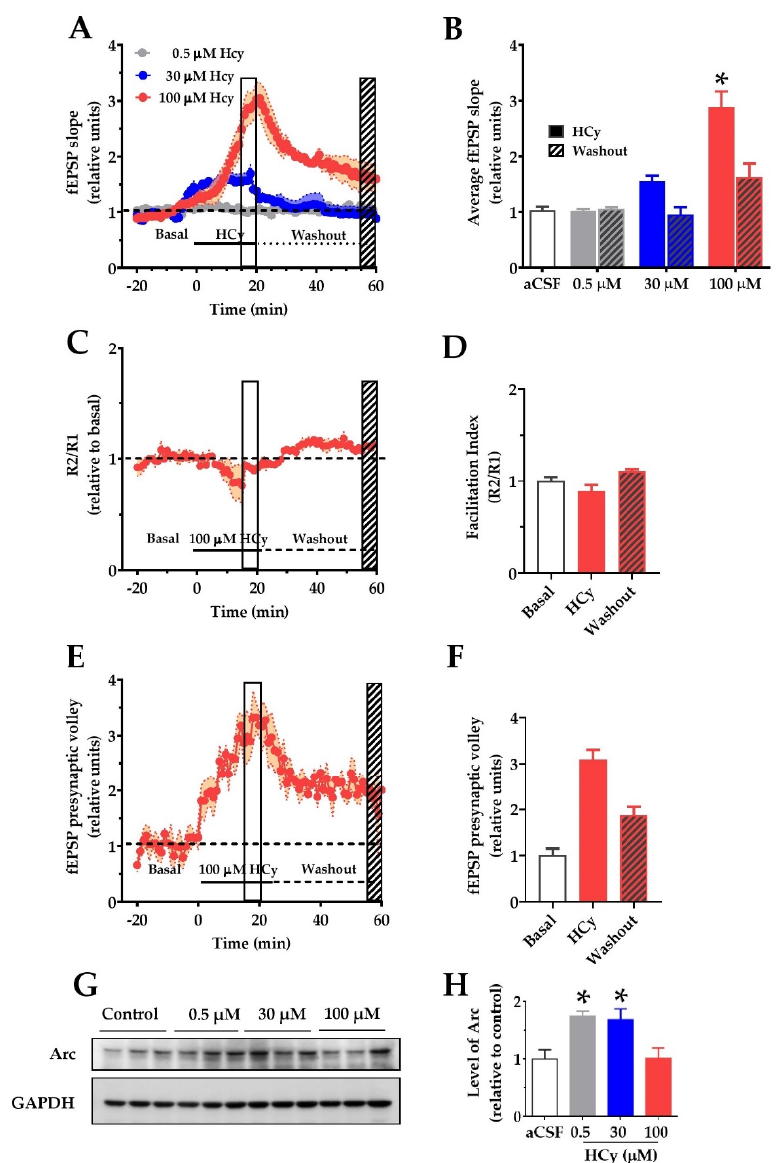
Figure 3. Homocysteine increases basal field excitatory post-synaptic potentials (fEPSP) amplitude in hippocampal slices. For recording of fEPSP amplitudes, HCy was bath-applied for 20 min in a bath (continuous line) at di ff erent concentrations followed by a 40 min washout on aCSF (dotted line). The open box marks the last 5 min of HCy treatment (15–20 min), and the scratched box marks the last 5 min of the washout (55–60 min). ( A ) Di ff erent concentrations of HCy over basal fEPSP (represented as a dotted line and quantified as the average fEPSP in (B)), ( B ) a plot of average fEPSP amplitude changes (relative to the aCSF control) according to (A). Only 100 µ M HCy shows significant di ff erences. After washout, 100 µ M HCy does not completely return to basal levels. ( C ) A paired-pulse facilitation (R2 / R1) test of 100 µ M HCy. ( D ) Quantification of (C) shows no significant di ff erences. ( E ) fEPSP of the pre-synaptic volley for 100 µ M HCy treatment. ( F ) Quantification of (E) shows significant di ff erences due to 100 HCy treatment. ( G ) Immunoblot of Arc, for di ff erent concentrations of HCy, with GAPDH as the loading control. ( H ) Densitometric analysis of (G), relative to the control condition. Bars are the mean ± SEM of a minimum of 8 di ff erent brain slices. * p < 0.05. A two-way ANOVA was performed followed by a Bonferroni post-test. Bars are the mean ± SEM. * p <